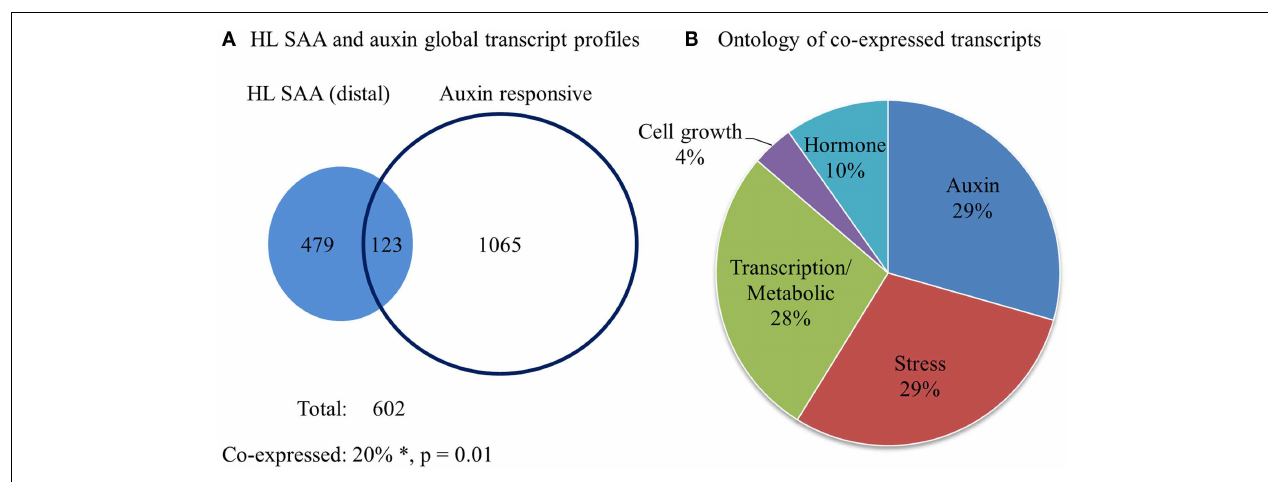
Nemhauser et al., 2006; Lee et al., 2009). *The percentage of co-expressed genes is greater than would be expected by chance by a two-sample z -statistic (equals 15.6, equivalent p = 0.01). (B) GO annotation (TAIR 10, 2012) of co-expressed genes between HL SAA and two or more auxin treatment